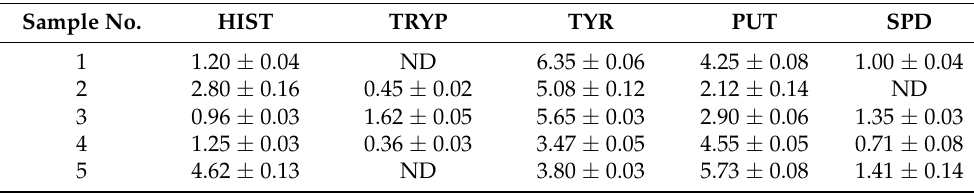
Corona Extra Concentration of biogenic amines (ug/mL) (mean ± standard deviation) Sample No. HIST TRYP TYR PUT